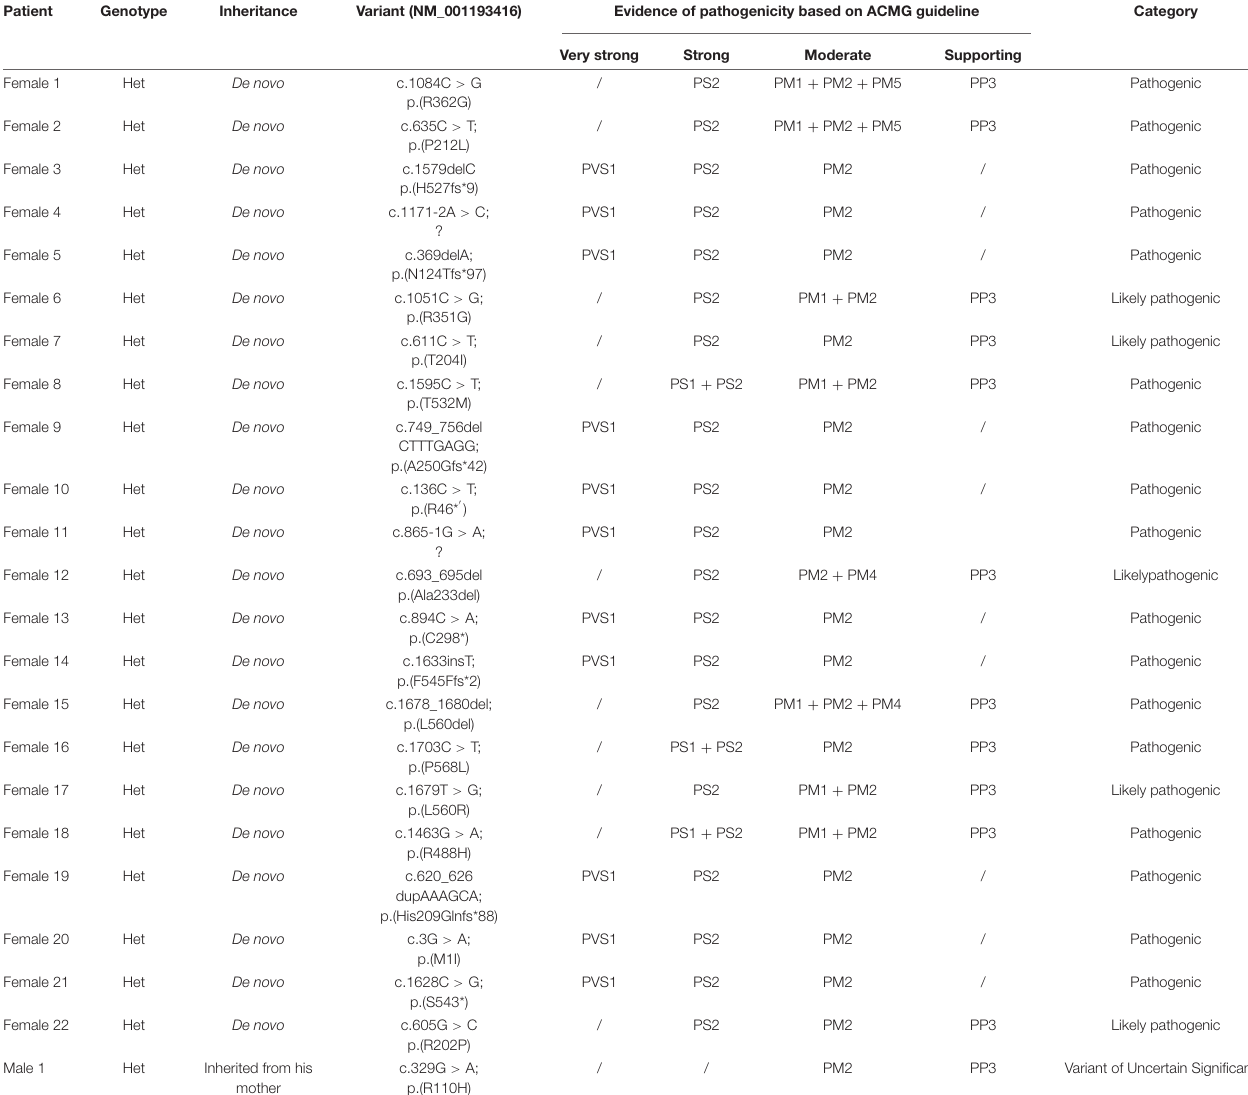
TABLE 1 | Clinical interpretation of variants detected in DDX3X by the ACMG guideline. Patient